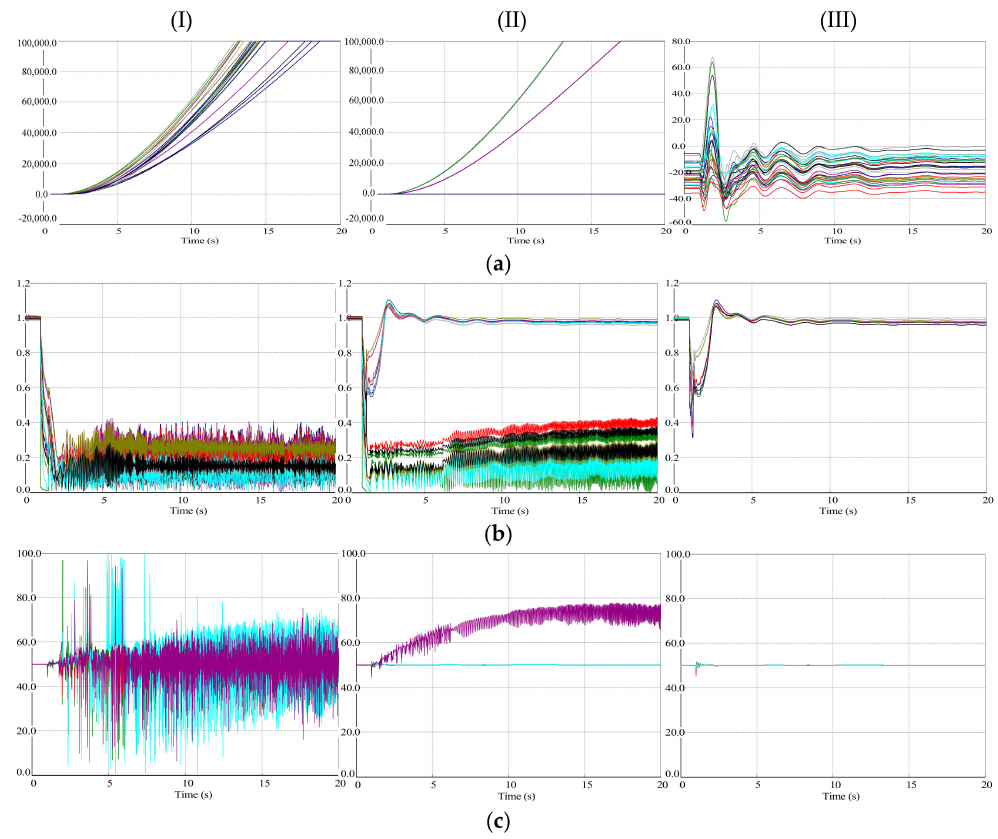
Figure 12. Dynamic trajectories of the test system. ( a ) Rotor angles of major generators ( ◦ ); ( b ) Voltages of end buses on cut-sets (p.u.); ( c ) System frequency (Hz).